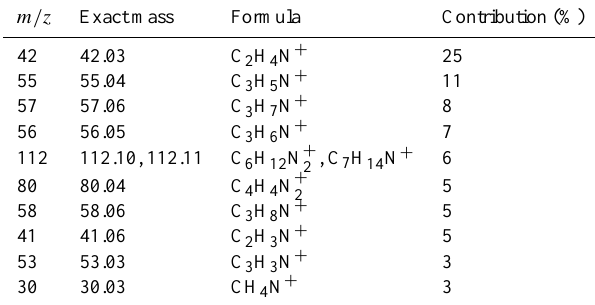
Table 7. Ten most dominant fragments of the C x H y N z series of the amino acid/amine factor, ordered according to their mass contribu- tion in percent.